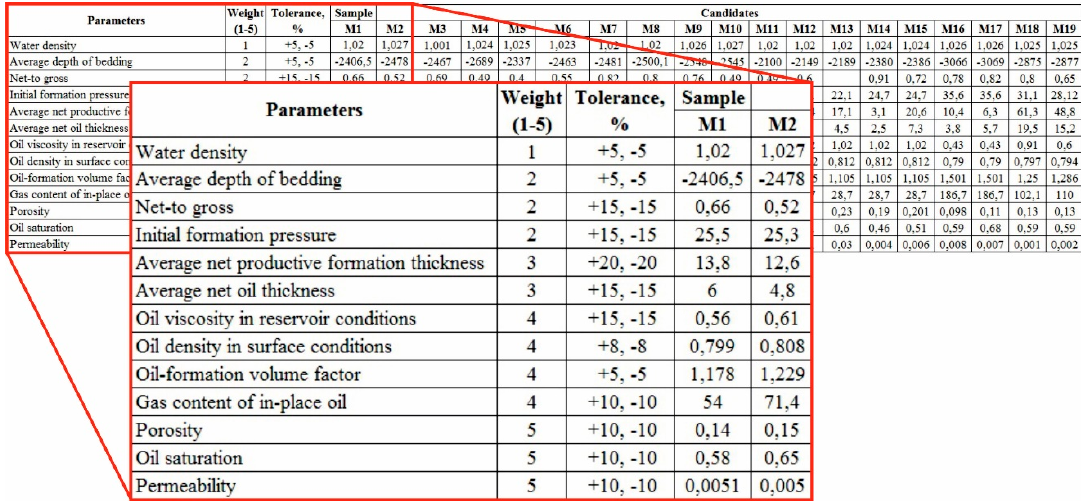
Figure 5. Initial data sampling for testing the search of analogies method.